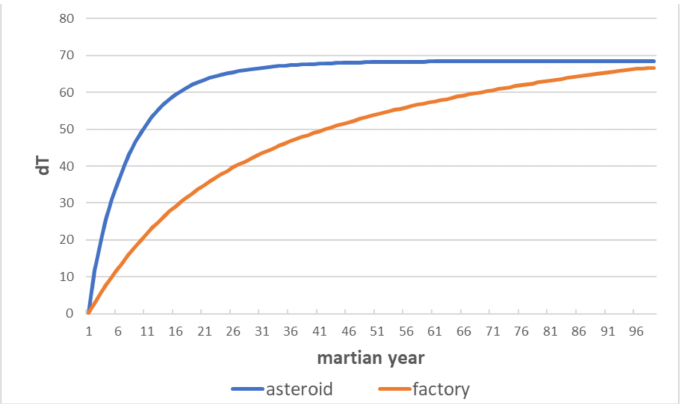
Figure 16. Average temperature rise on Mars over 100 simulation years after the initial